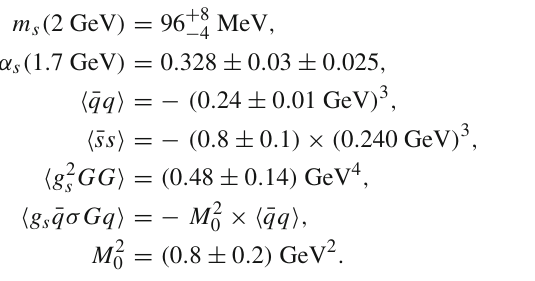
Fig. 1 The correlation functions Π η = 1 . 8 GeV 2 M 2 B